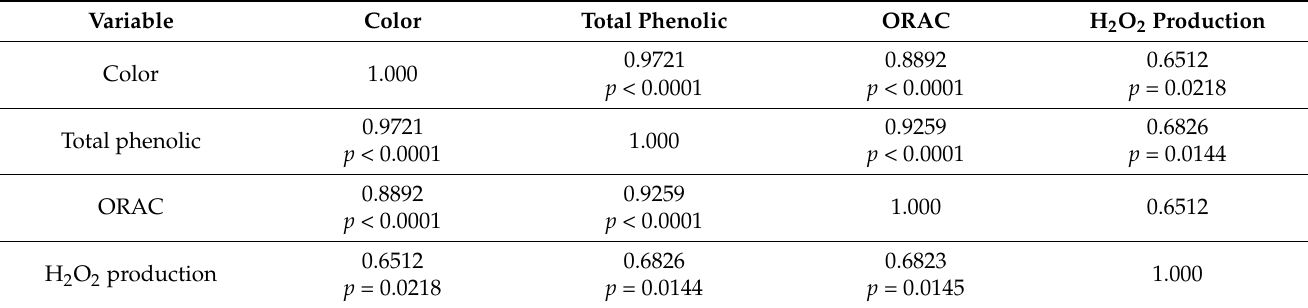
Table 3. Pearson correlation coefficients and correlation matrix.